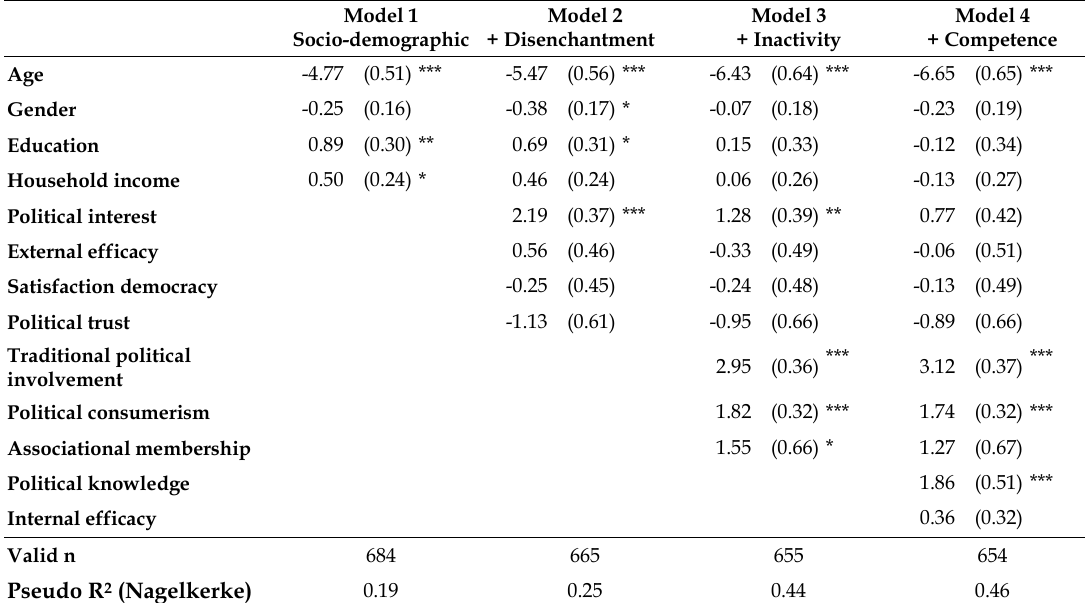
Table 6: The complete story of Internet